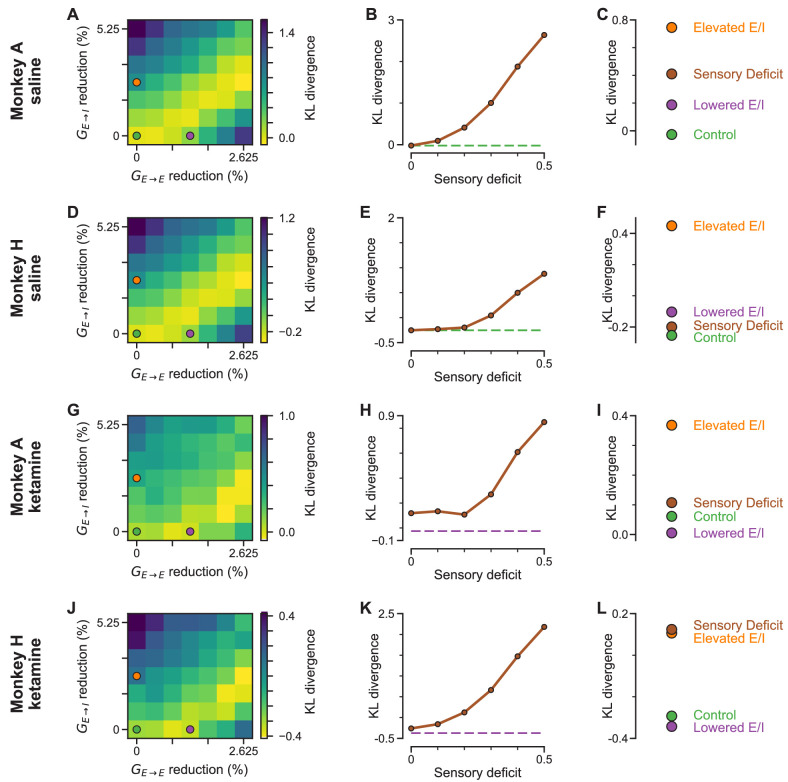
Kullback–Leibler (KL) divergence from monkey behavior with saline or ketamine to circuit models with various perturbations.(A) KL divergence between Monkey A saline data and circuit models with various degrees of NMDA-R hypofunction on excitatory (GE→E) and inhibitory (GE→I) neurons. Lower KL divergence between data and model means the psychometric functions are more similar between the two. The green, purple, and orange dots respectively denote the control, lowered E/I, and elevated E/I circuit models used in Figure 7. (B) KL divergence between Monkey A saline data and circuit models with various degrees of sensory deficit. Green dashed line shows the KL-divergence between Monkey A saline data and the control model, which is the lowest among the four circuit models used in Figure 7 (see C). (C) KL divergence between Monkey A saline data and the control, lowered E/I, and elevated E/I, and sensory deficit circuit models used in Figure 7. The control model has the lowest KL divergence compared to Monkey A saline data. (D–F) Same as (A–C) but with comparisons made with Monkey H saline data. (G–I) Same as (A–C) but with comparisons made with Monkey A ketamine data. Monkey A’s empirical lapse rate is incorporated into the psychometric function of the circuit models for computing the KL divergence. (H) Purple dashed line shows the KL-divergence between Monkey A ketamine data and the lowered E/I model, which is the lowest among the four circuit models in (I). (J–L) Same as (G–I) but with comparisons made with Monkey H ketamine data.